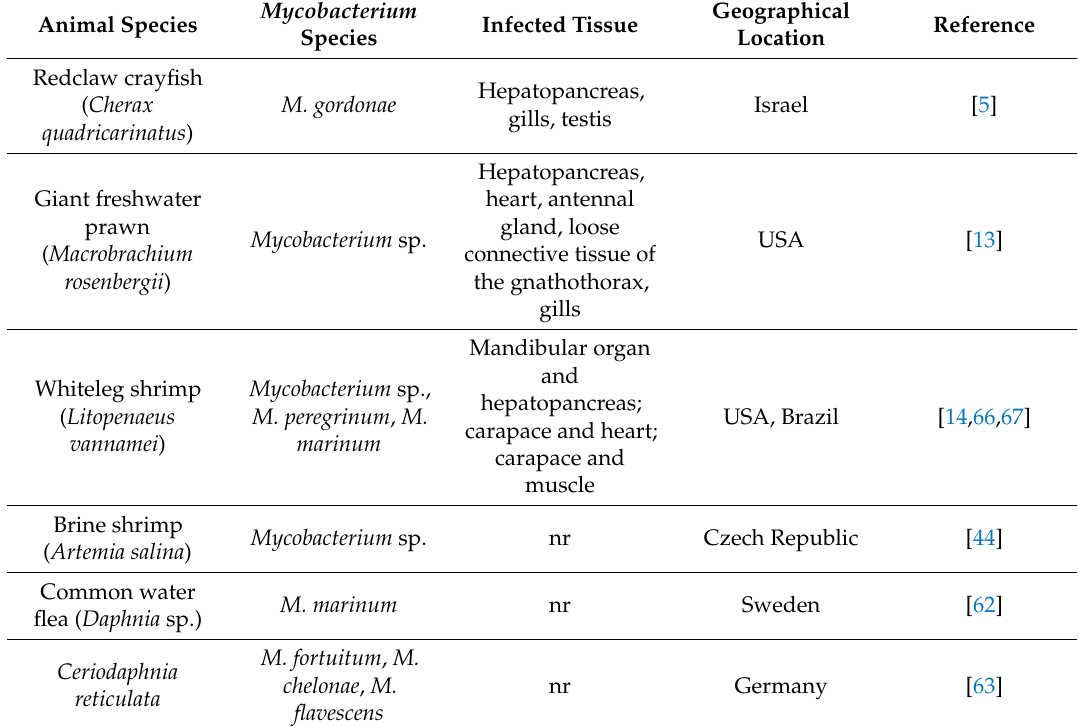
Table 2. Summary of crustaceans’ mycobacterioses, including animal species, Mycobacterium species, infected tissue, geographical location, and